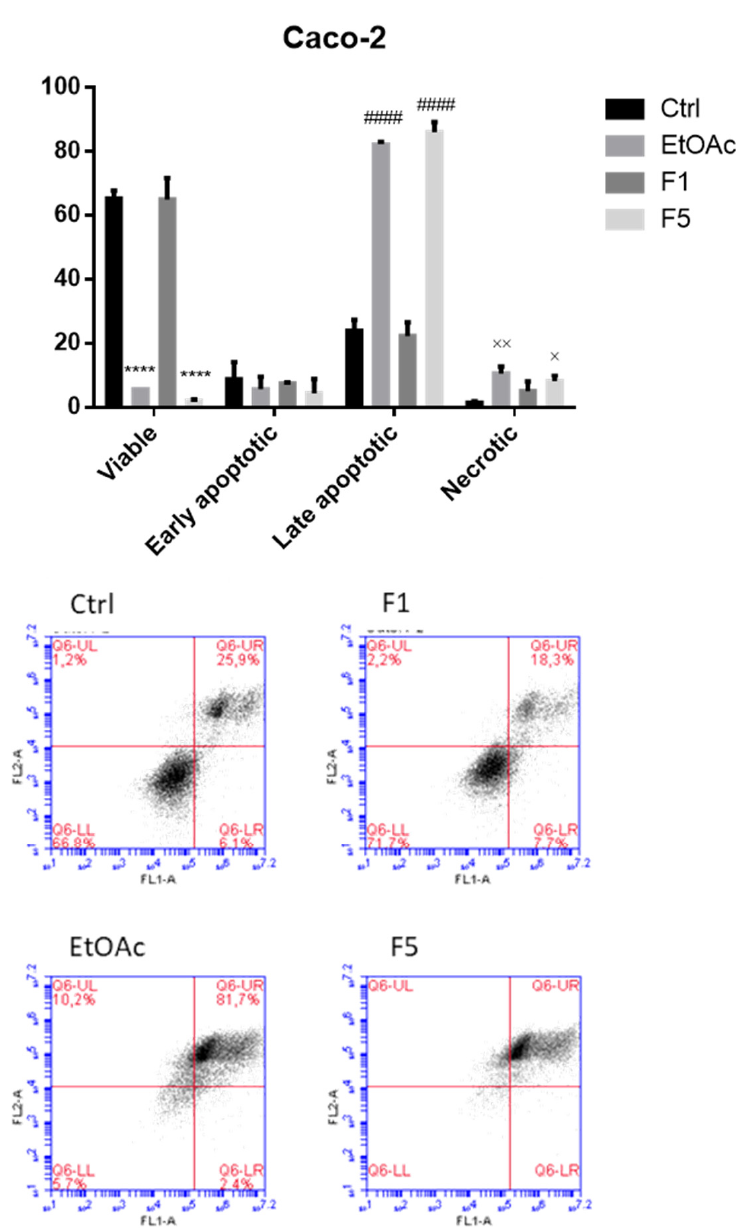
Figure 4. Detection of apoptosis/necrosis after 48 h treatment with F. vesiculosus samples via annexin V-FITC/PI labelling. The populations of early apoptotic cells, late apoptotic cells, necrotic cells, and viable cells were evaluated as a percentage of total cells and are presented as the means ± SEM of at least three independent experiments (* p < 0.05, ** p < 0.01, **** p < 0.0001 when compared with control; the symbols *, #, and × were used to express statistical significance within the viable, apoptotic, and necrotic cells, respectively).